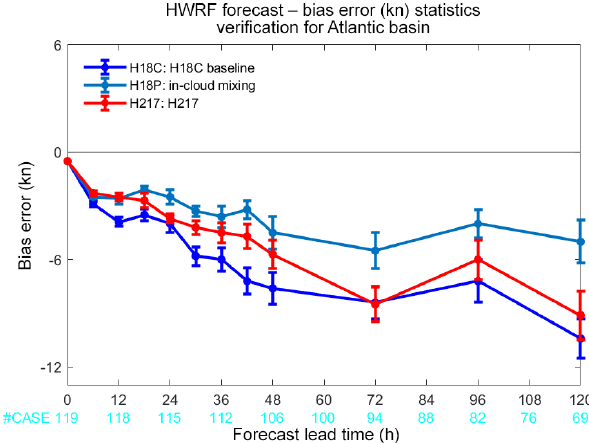
Figure 16. Maximum wind speed bias error (knot) as a function of forecast lead time (h) averaged over all tested storms and cycles. Av- erage bias errors are shown for the 2018 HWRF model baseline (H18C; blue), 2018 HWRF model with the inclusion an in-cloud turbulent-mixing parameterization (H18P; cyan), and 2017 opera- tional HWRF model (H217; red). The storms tested included Her- mine (2016), Harvey (2017), Irma (2017), Maria (2017), and Ophe- lia (2017). The vertical bars indicate the root-mean-square errors (RMSEs). The total number of simulation cases for various forecast lead times is indicated by the cyan labels at the bottom (courtesy of Sergio Abarca at EMC,